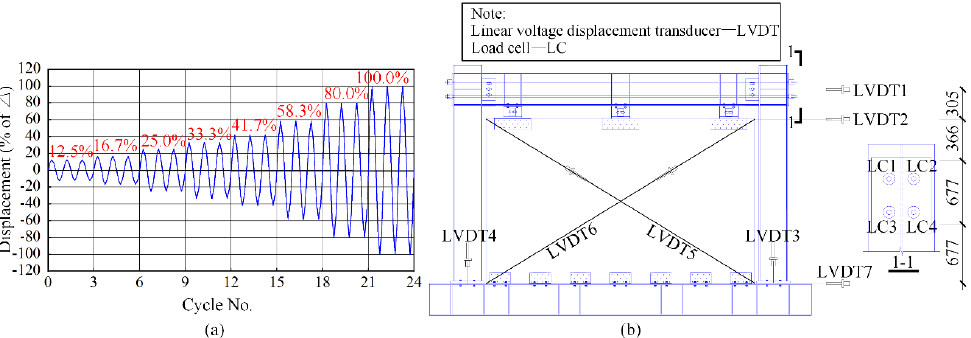
Figure 3. Test arrangement: ( a ) the loading protocol; ( b ) the data acquisition (all dimensions are in mm).